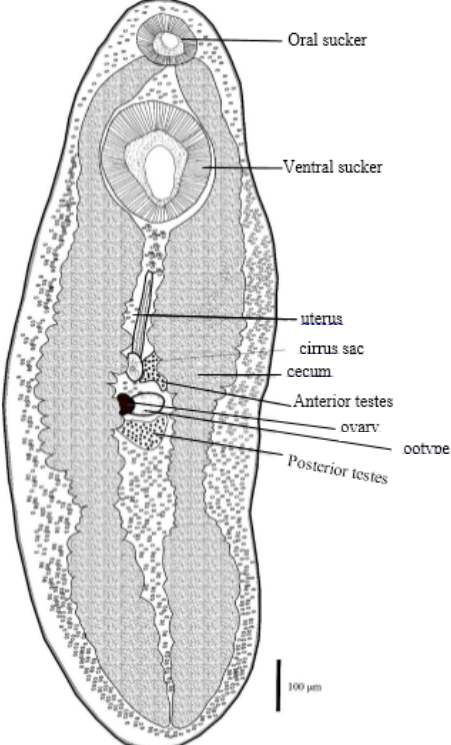
F IGURE 2. Drawing line of Clinostomum complanatum metacercariae from Gheshlagh River A